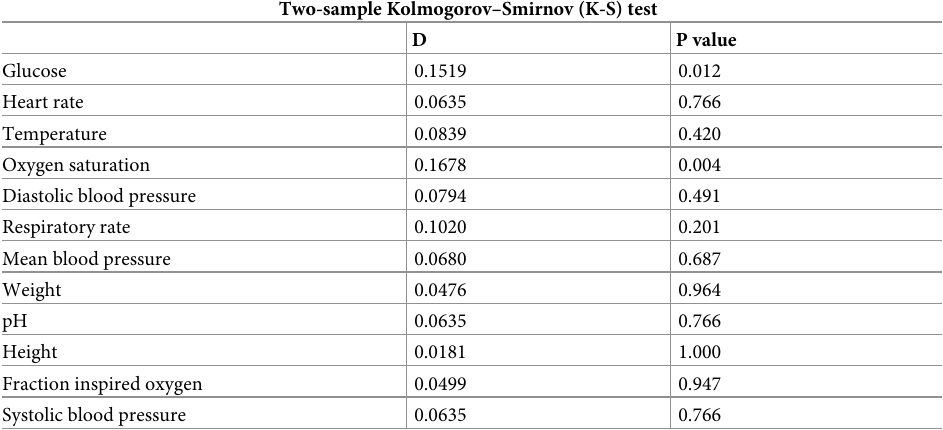
Table 5. Kolmogorov–Smirnov (K-S) test for the distribution of fluctuation between LSTM-C and LR-C for each chart